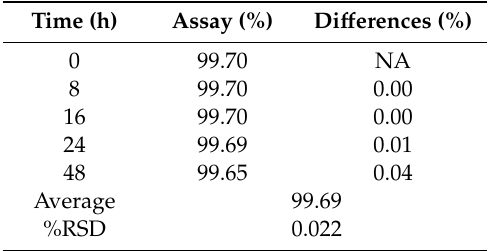
Table 4. Stability results of standard scopoletin using qNMR.